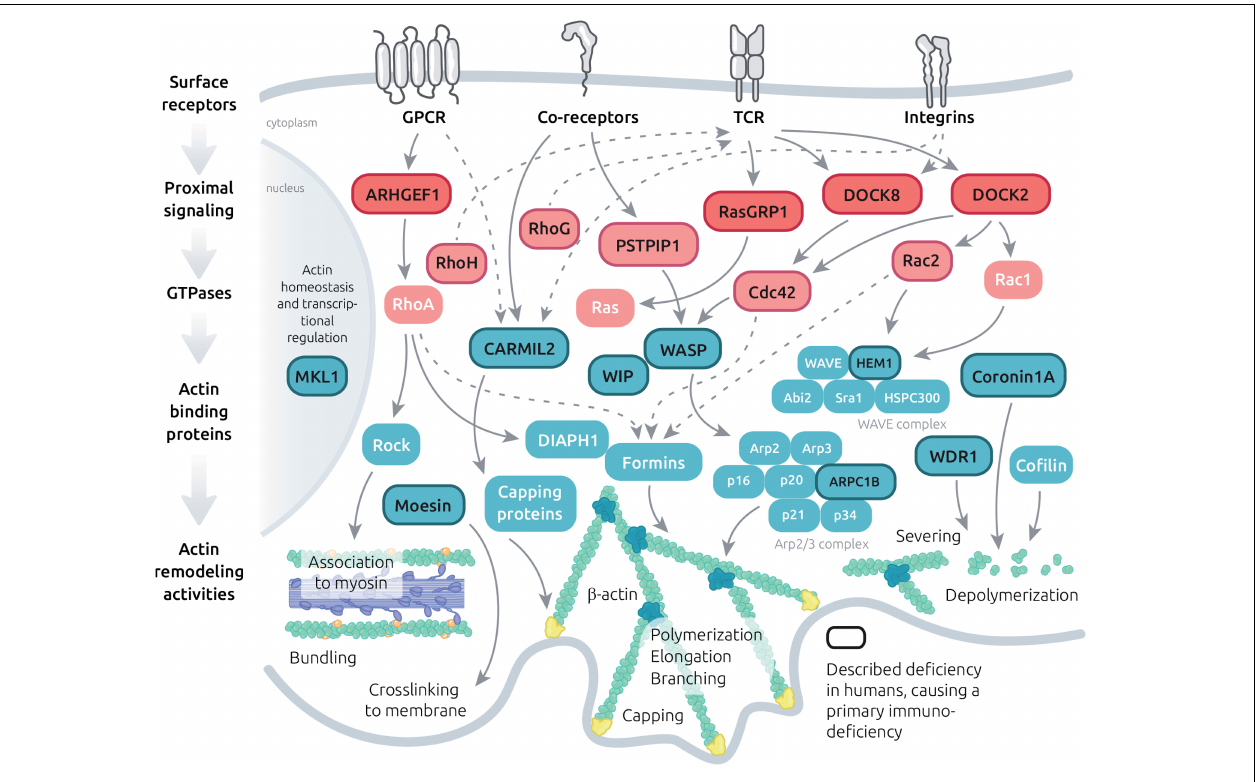
FIGURE 3 | Molecular machinery controlling actin dynamics in T cells. Schematic view of the major signaling events leading to actin cytoskeleton remodeling downstream key T cell surface receptors. The represented molecules include GTPase regulators, GTPases and actin binding proteins with diversified actin remodeling activities. A focus is made on molecules which have been implicated in PID (dark letters and lines) and on their interactors.